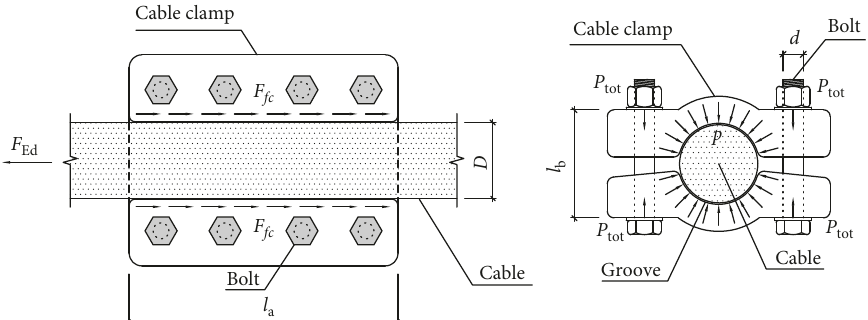
Figure 3: Schematic diagram of the antisliding mechanics of a cable clamp.